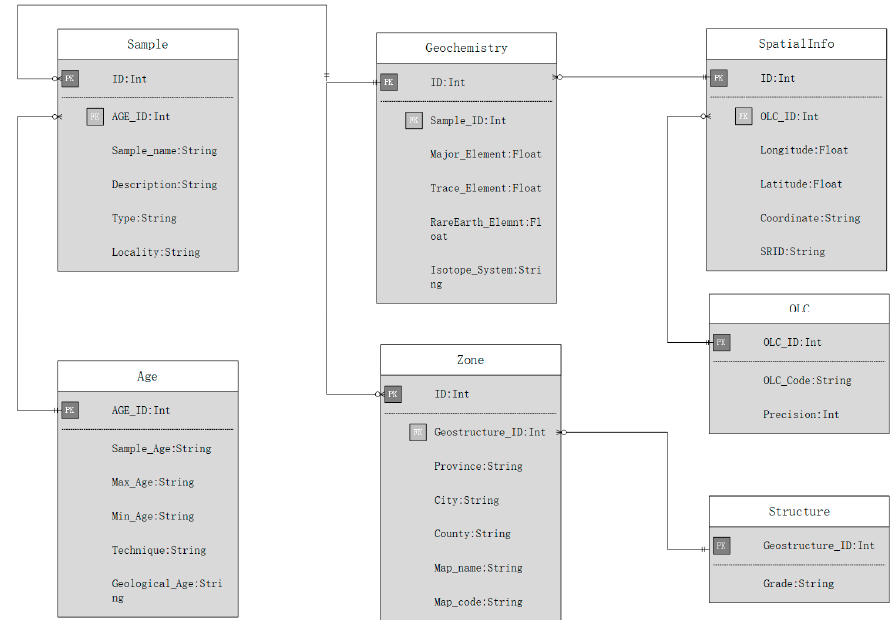
Figure 4. Table designed for geochemical data.